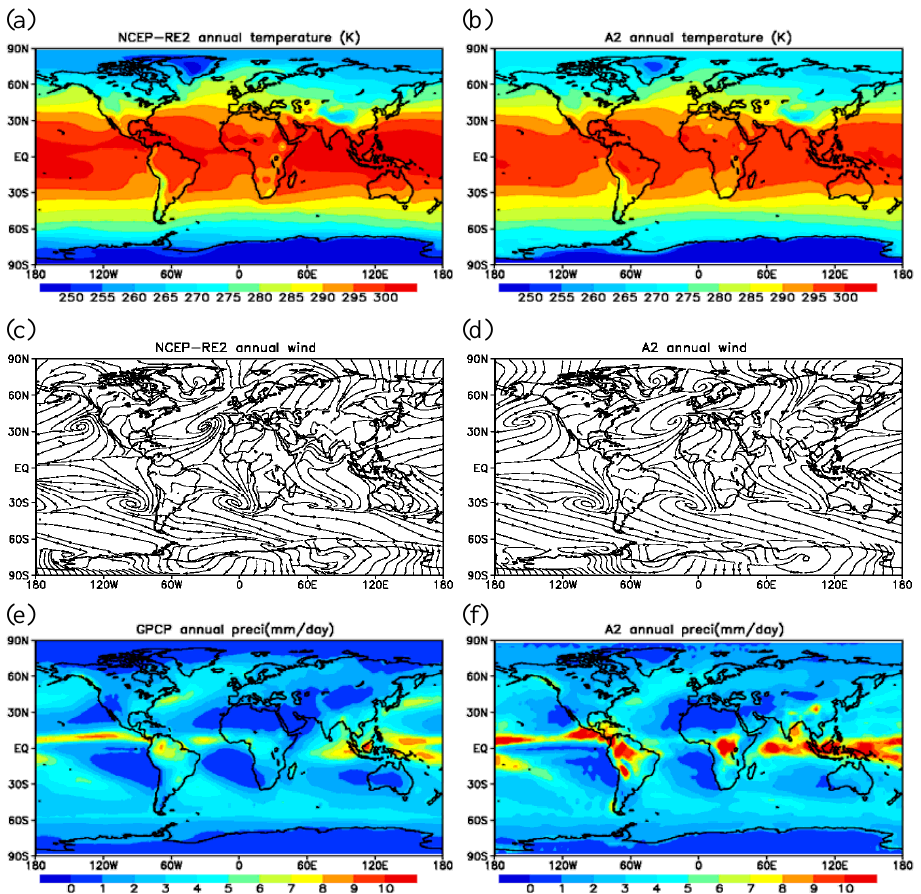
Fig. 2. Comparison of meteorological fields from the A2 simulation (right panels) with those from observation or reanalysis data (left panels). Top: near surface temperature (K); Middle: near-surface streamline; Bottom: precipitation (in mmday − 1